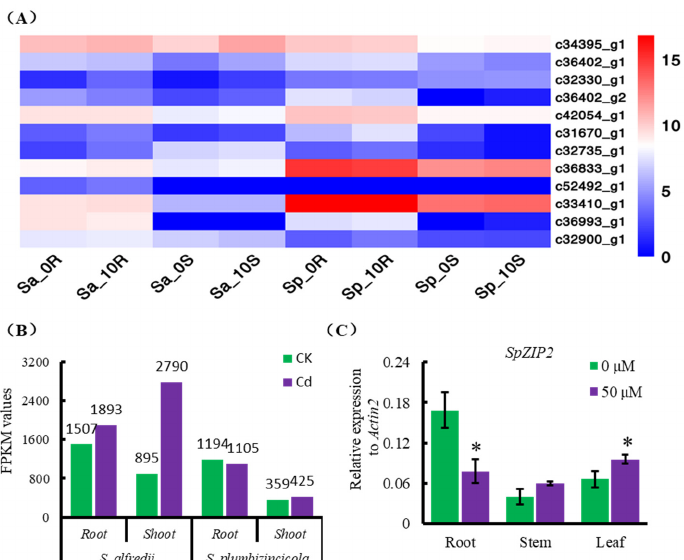
Figure 1. Expression pattern of Zinc (Zn)-regulated and iron (Fe)-regulated transporter-like proteins (ZIPs) in Sedum plumbizincicola (S. plumbizincicola ) and Sedum. alfredii (S. alfredii ). ( A ) Expression of ZIP genes in S. plumbizincicola and S. alfredii in response to Cd stress. Sp: S. plumbizincicola . Sa: S. alfredii . 0R: Roots without Cd treatment. 10R: Roots with Cd treatment. 0S: Shoots without Cd treatment. 10S: Shoots with Cd treatment. ZIP1 : c33410_g1 ; ZIP2 : c34395_g1 ; ZIP3 : c31670_g1 ; ZIP4 : c36833_g1 . ( B ) FPKM values of ZIP2 in roots and shoots under normal or Cd stress conditions in S. plumbizincicola and S. alfredii . ( C ) Expression of SpZIP2 in roots, stems and leaves in response to Cd treatment in S. plumbizincicola . Values are means ± SD, n = 3. Statistical significance was tested by Student’s t-tests. Differences were deemed significant at p < 0.05 (*).